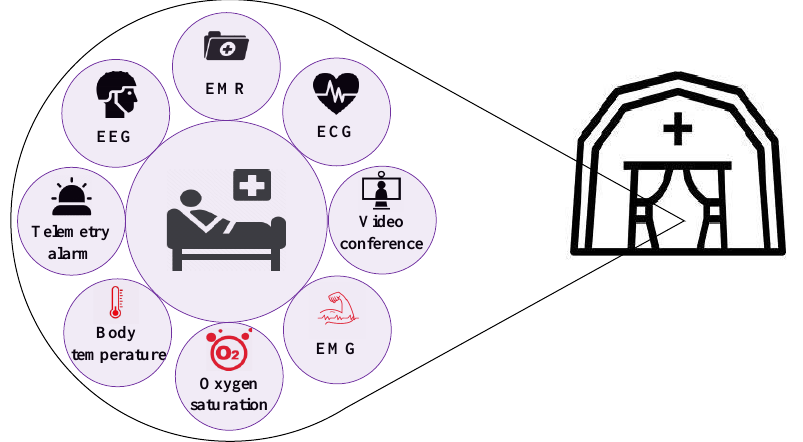
Figure 1. An example of MIoT applications in a field hospital.